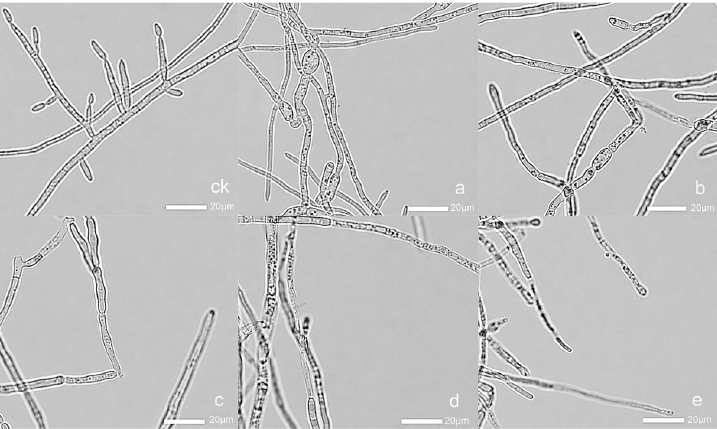
Fig 2. The effect of canthin-6-one on hyphal morphology. ck, blank control; a–e, treatment with 8.0, 16.0, 32.0, 64.0, 128.0 μ g mL -1 canthin-6-one, respectively. https://doi.org/10.1371/journal.pone.0250712.g002 47.97%, respectively (Fig 3A). After high-temperature treatment (100˚C and 121˚C), the anti- fungal activity decreased to 41.75% and 39.61%, respectively, indicating that canthin-6-one was thermally unstable and high-temperature treatment should be avoided. As shown in